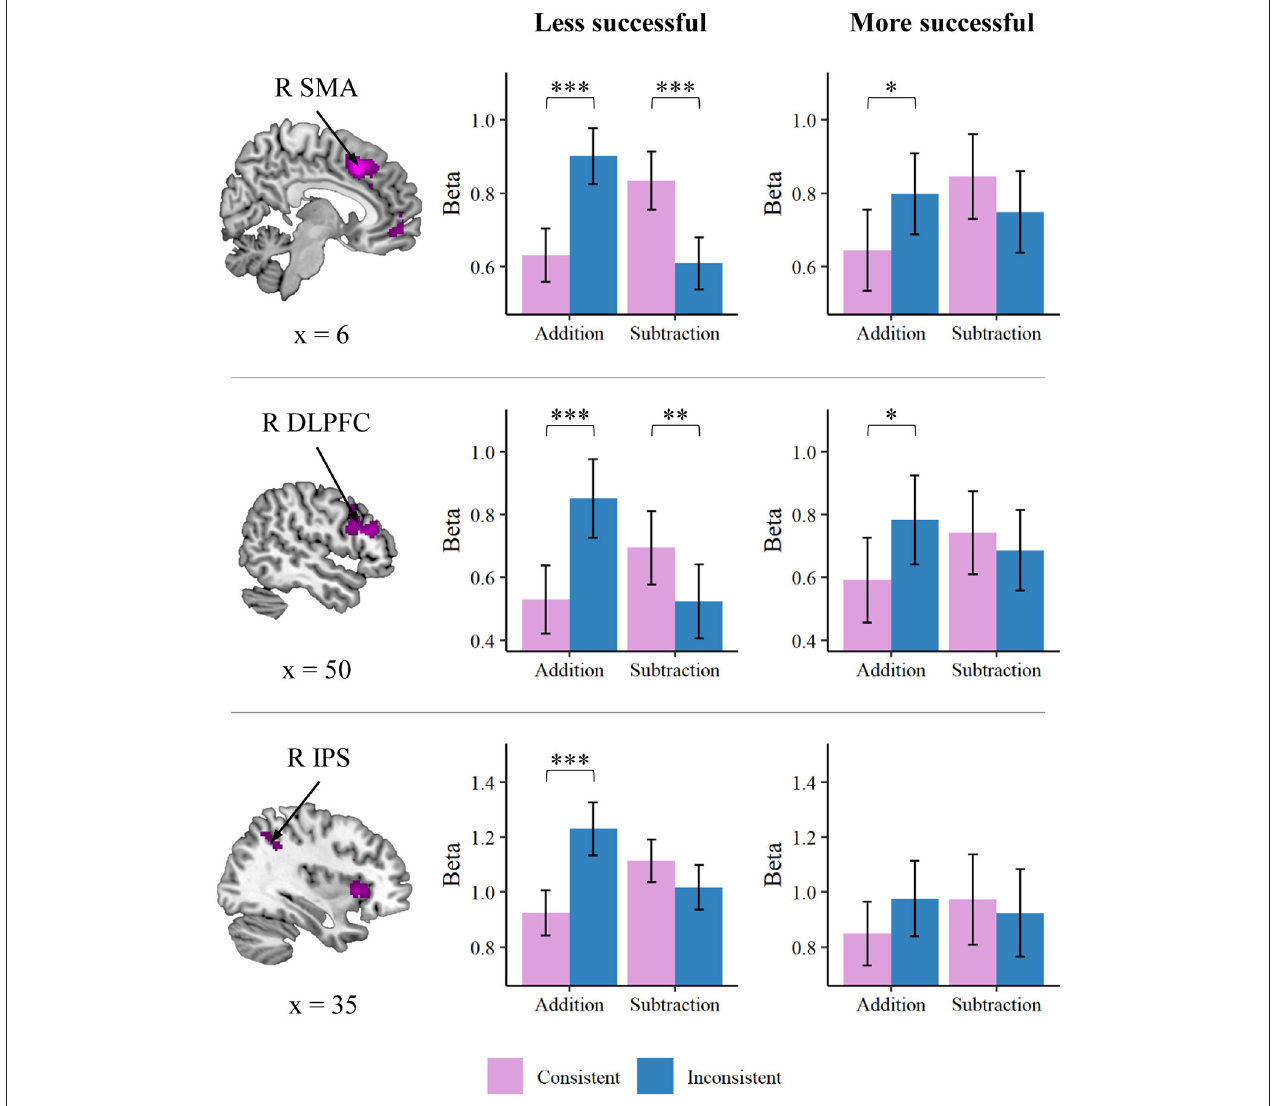
FIGURE 4 | Brain regions that showed an interaction between group (more/less successful), consistency, and operation. The consistency by operation interaction was more prominent for the less successful than for the more successful word problem solvers in the supplementary motor area (SMA), right dorsolateral prefrontal cortex (DLPFC), and the right intraparietal sulcus (IPS). * p < 0.05, ** p < 0.01, *** p <